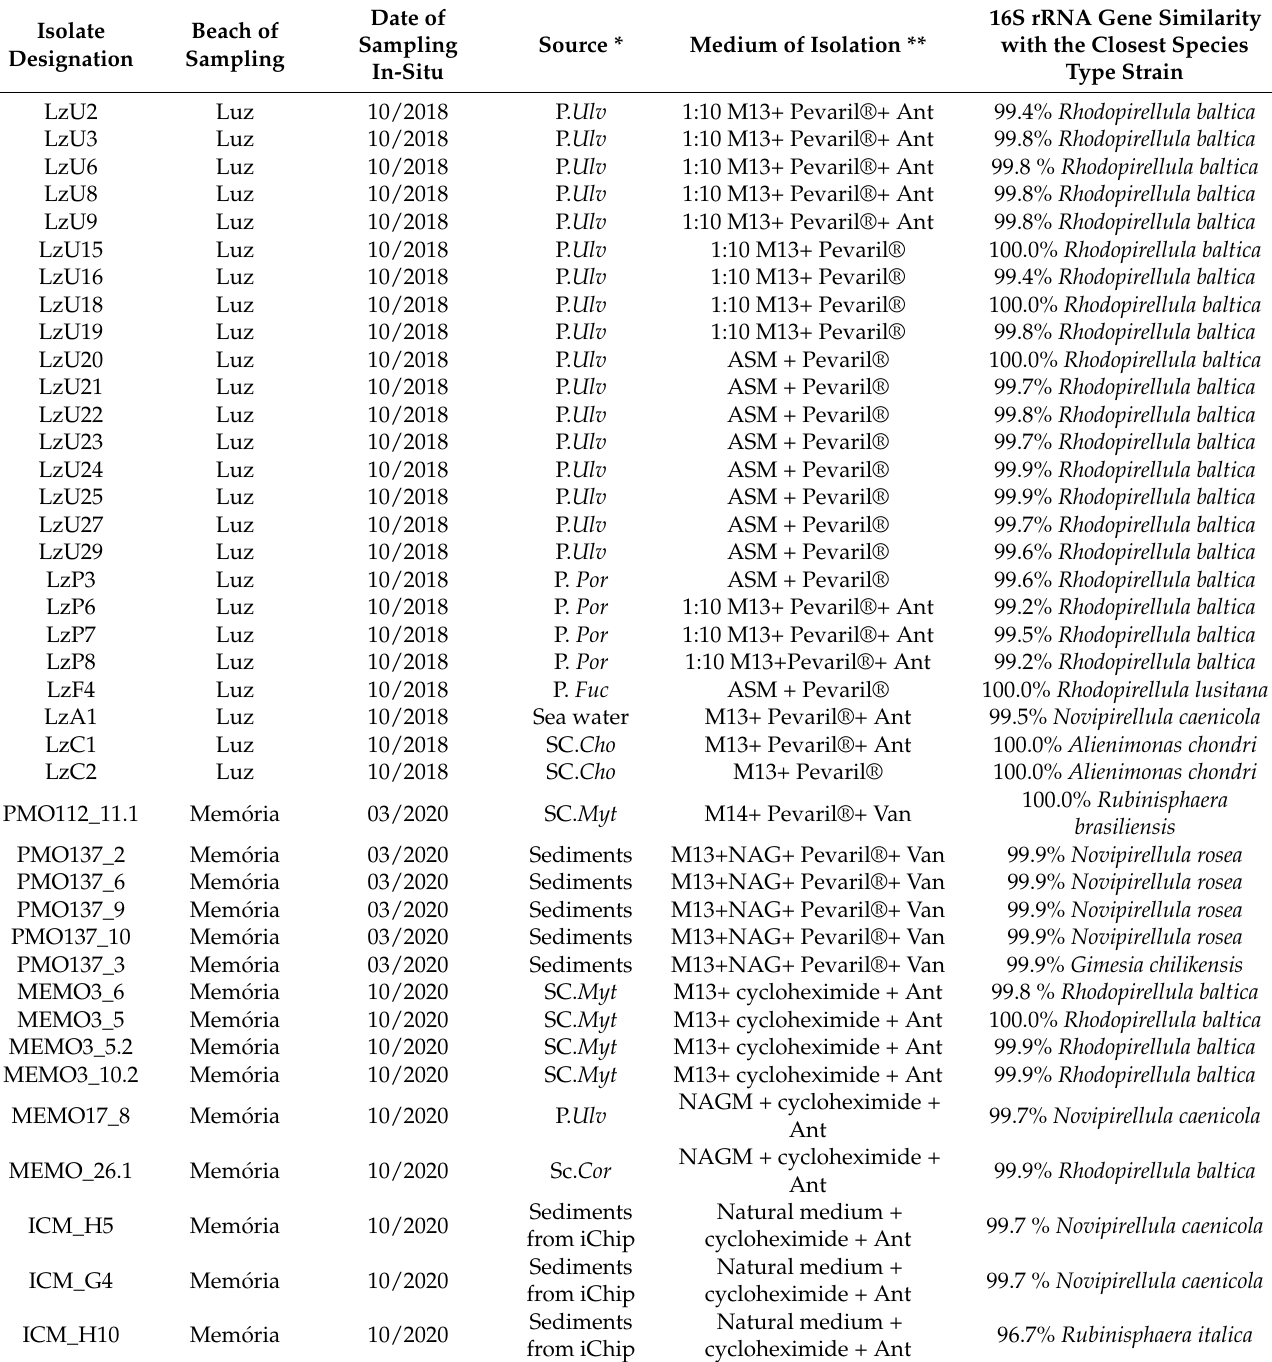
Table 3. Data on isolates obtained regarding their sampling location, date of sampling, source of isolation, medium of isolation, and